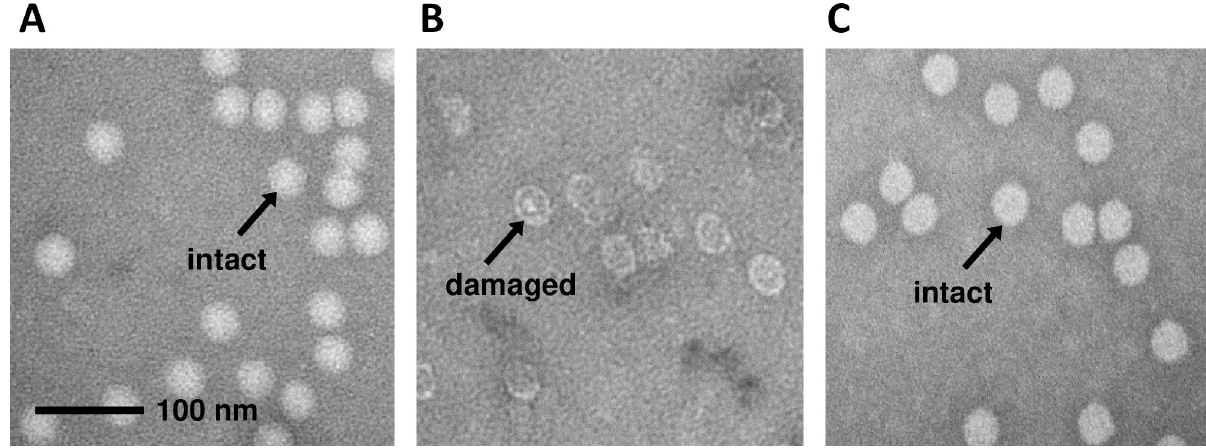
Fig 3. Ultrastructural analysis of irradiated poliovirus. Electron micrographs are shown of PV1-S that had been A ) not irradiated, B ) irradiated to 45 kGy without MDP, or C ) irradiated to 45 kGy in the presence of MDP. The images are representative of > 700 particles assayed for each group. The length of the scale bar in Panel A is 100